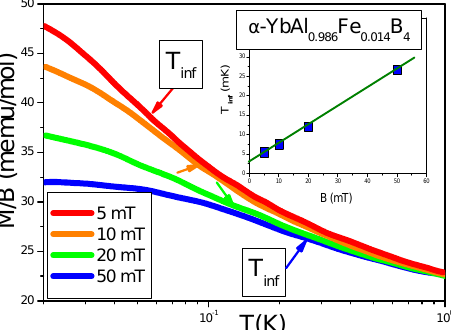
Figure 19. Magnetization M ( T ) versus T for B values shown in the legend. The data are taken from [34]. M ( T ) is displayed versus temperature on a logarithmic scale. The approximate location of the inflection point at temperature T inf ( B ) (versus magnetic field B ) is indicated by the arrow. At T = T inf ( B ) the HF metal α YbAl 1 x Fe x B 4 enters the crossover region, separating the NFL behavior − − from the LFL one, see Figure 7. The inset displays T inf versus magnetic field B